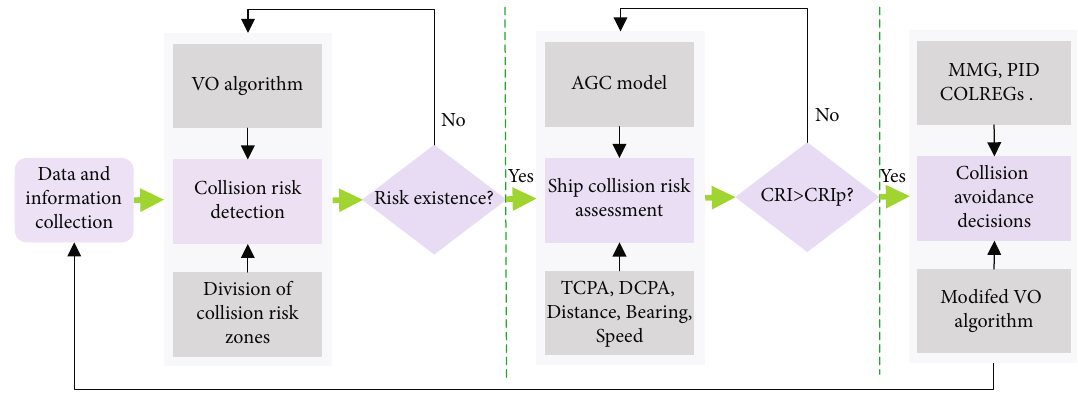
Figure 2: The framework of collision avoidance